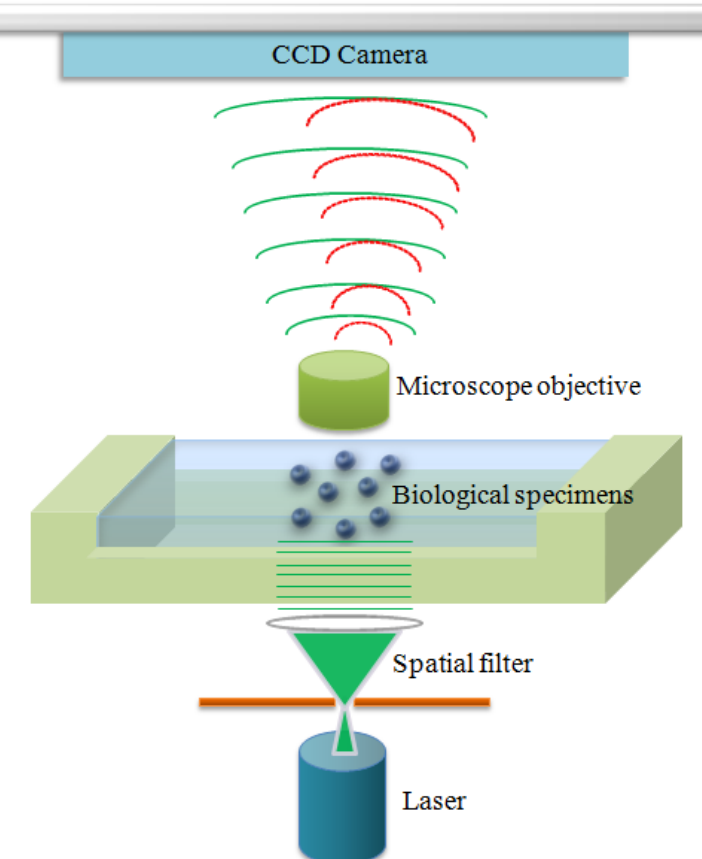
Figure 1. Experimental setup for recording the Gabor digital hologram of